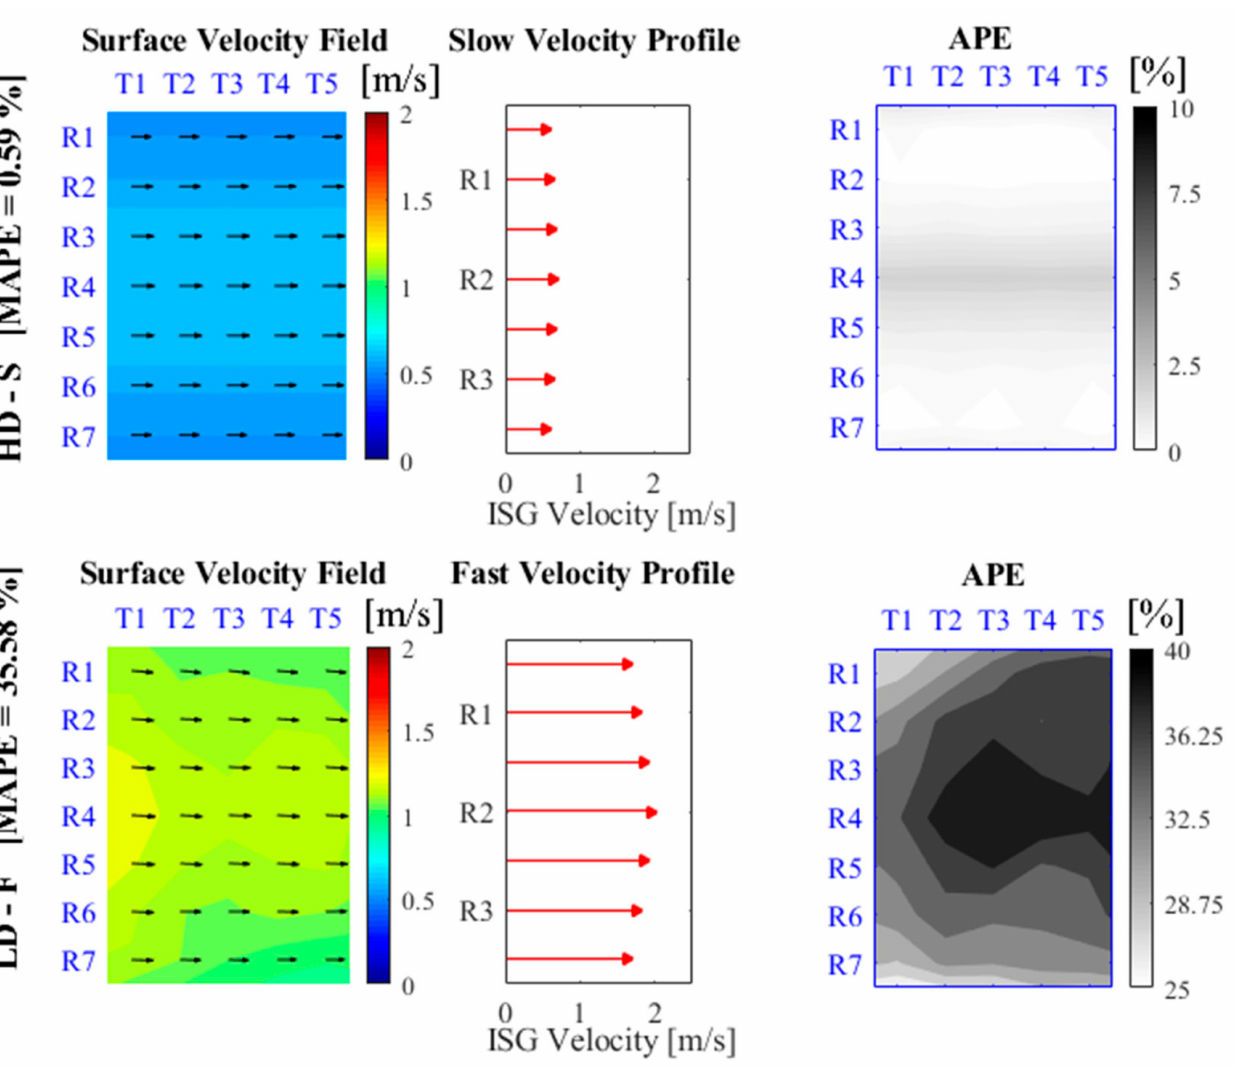
Figure 6. The best (lowest MAPE ) and the worst (highest MAPE ) cases under the ID-CON scheme (first set of simulations: frame-rate = 4 fps, d = 30 s). Top graphs refer to the best case (HD-S configuration, MAPE = 0.59%), while bottom graphs refer to the worst one (LD-F configuration, MAPE = 35.58%). The indicator MAPE (Mean Absolute Percentage Error) is the mean APE i over the entire area of investigation. For each case, the surface velocity field estimated by PIVlab (left panel), the cross-section velocity profile imposed in the ISG (middle panel) and the map of APE i (right panel), derived by RAV module after comparison between estimated and imposed velocities at each node, are